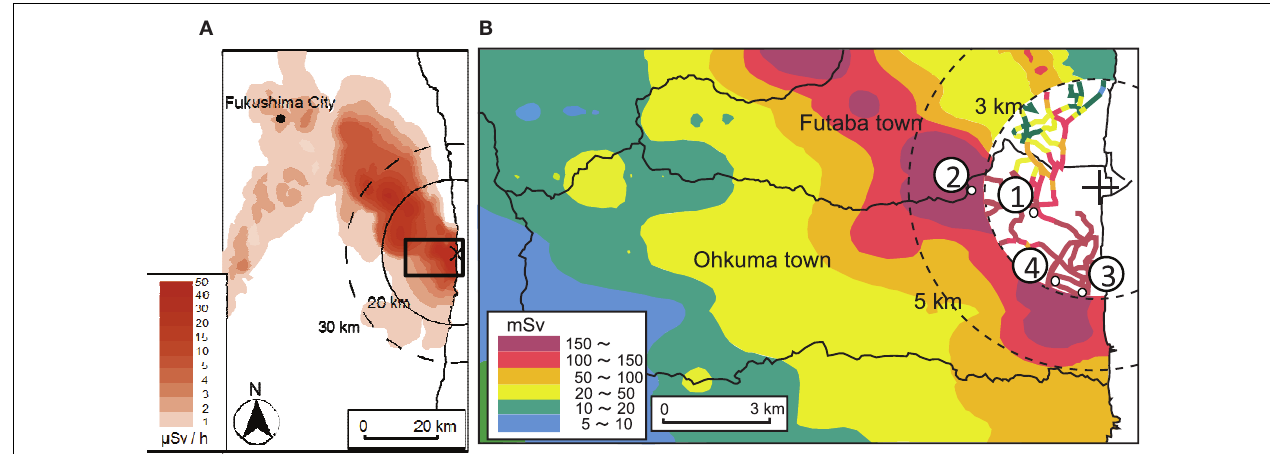
FIGURE 1 | Map of dose at 1m above the ground . Data from Ministry of Education, Culture, Sports, Science and Technology, Japan (MEXT, 2013). (A) Prediction of the accumulated dose during 1year; 3/11/2011–2/11/2012. (B) Sampling location collected in March 2012.